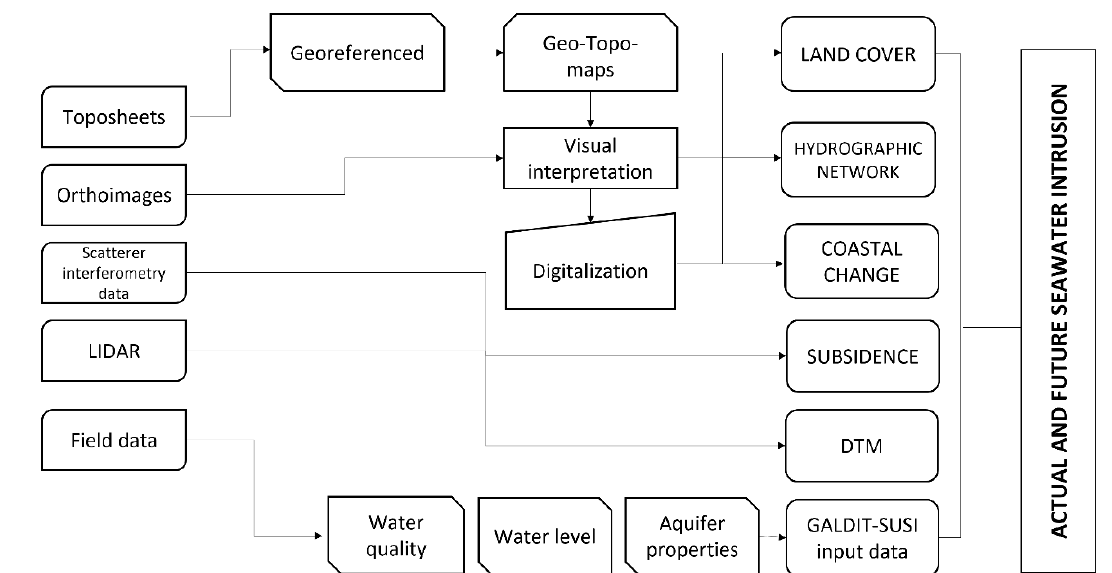
Figure 4. Workflow for spatial data processing and SI vulnerability.